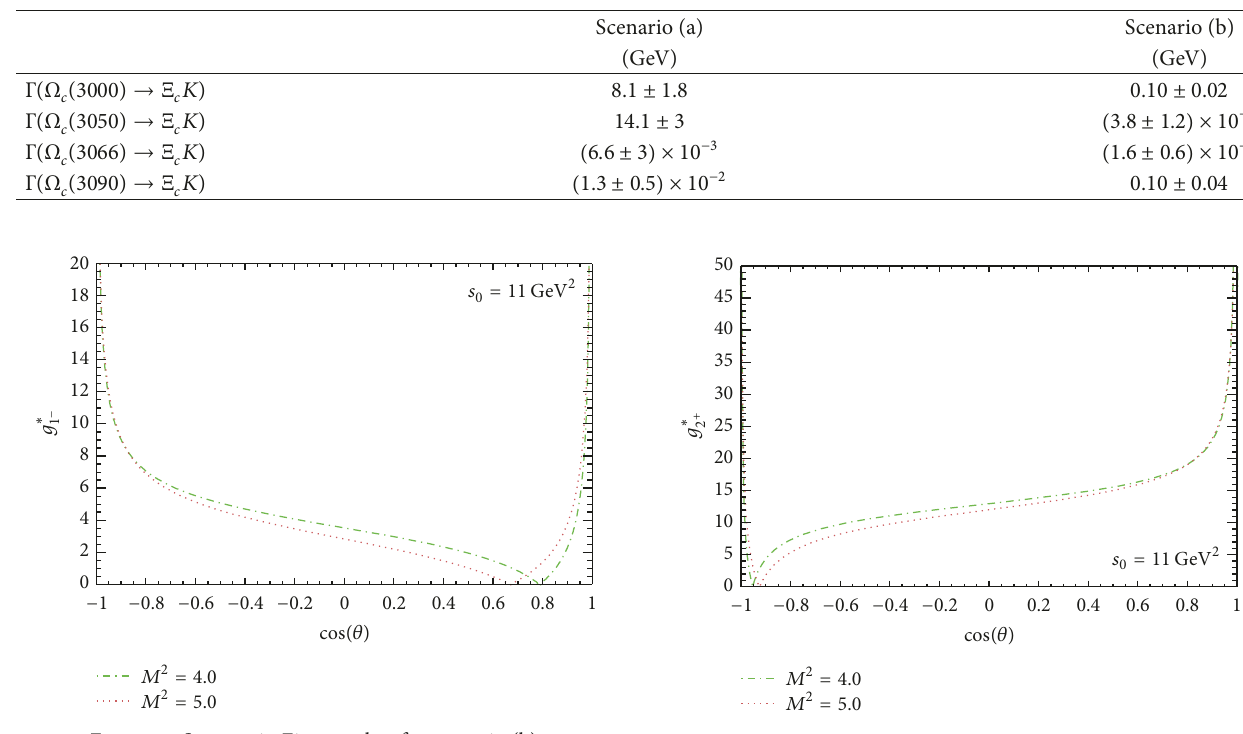
Table 1: Decay widths for the two-scenarios considered are shown.